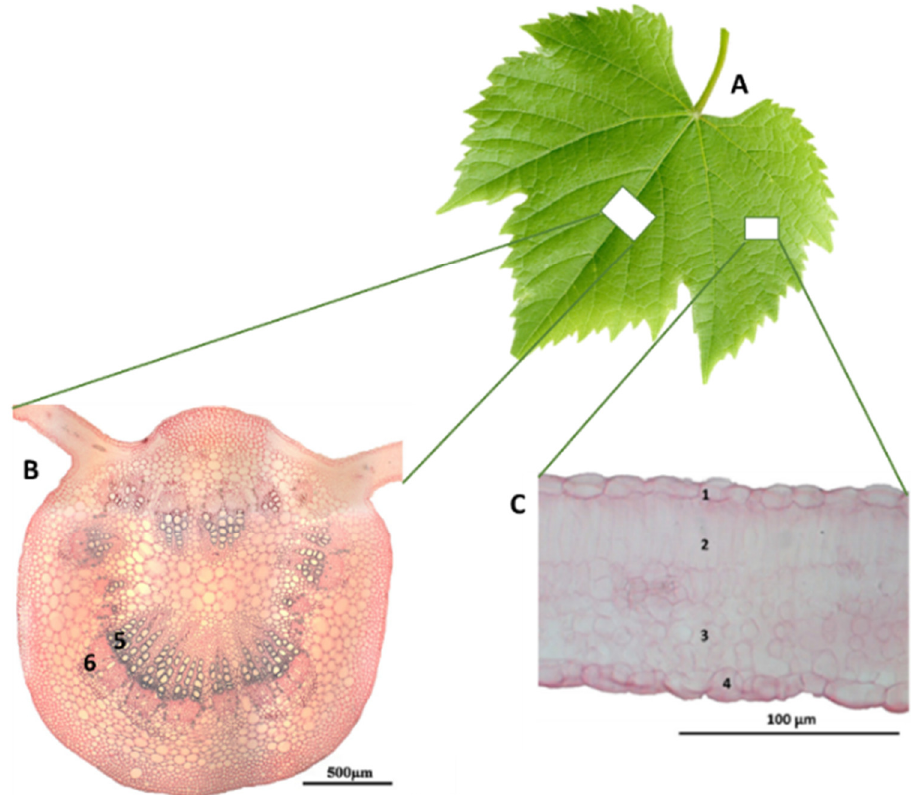
Figure 3. Vitis vinifera leaf ( A ), a cross-section of the main vein ( B ) and mesophyll ( C ). 1, Upper epidermal cells; 2, palisade parenchyma; 3, spongy parenchyma; 4, lower epidermal cells; 5, xylem; 6, phloem. Adapted from Cosme et al. [8].